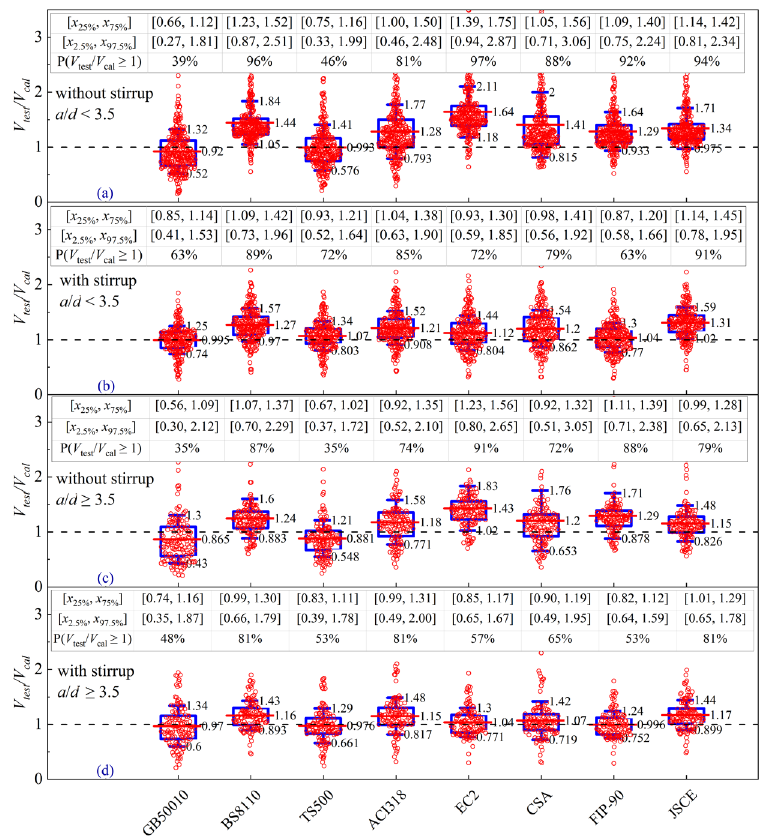
Figure 7. Codes: prediction results for beams without stirrup versus ( a ) a / d < 3.5 and ( c ) a / d ≥ 3.5 and for beams with stirrup versus ( b ) a / d < 3.5 and ( d ) a / d ≥